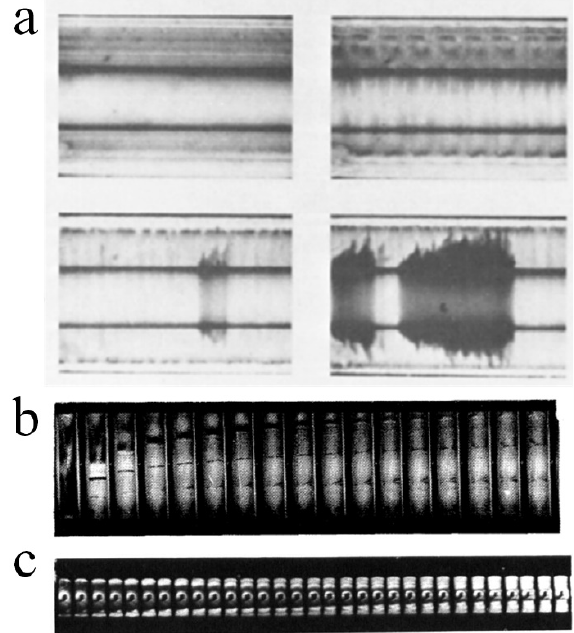
Figure 3. ( a ) Cellular flow in a nematic LC. Reprinted with permission from Ref. [22]. Copyright 1976 Elsevier. ( b ) Propagation process of the director wave. Reprinted with permission from Ref. [23]. Copyright 1982 American Physical Society. ( c ) Propagation of the 2D axisymmetric soliton. Reprinted with permission from Ref. [27]. Copyright 1987 Taylor & Francis.